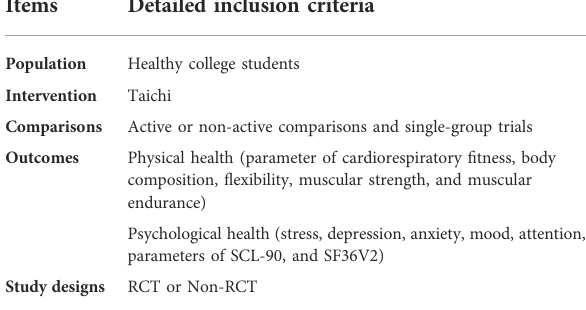
TABLE 1 Inclusion criteria according to the PICOS